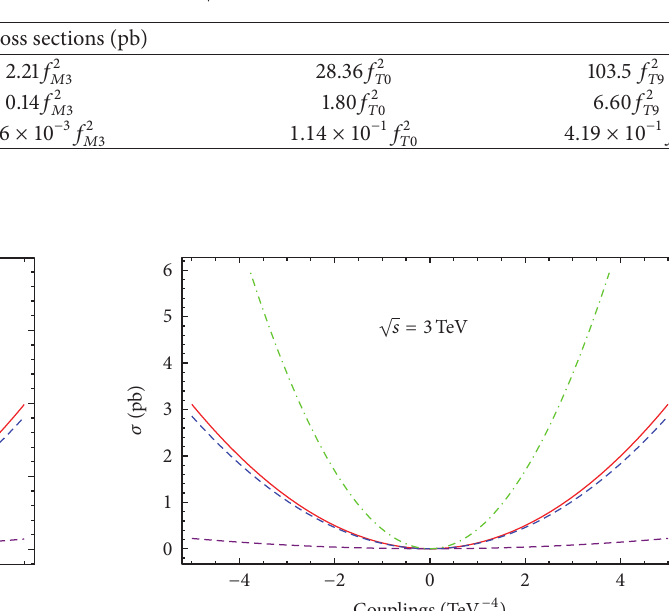
Table1:Thetotalcrosssectionsasfunctionofanomalous 𝑓 𝑀2 /Λ 4 , 𝑓 𝑀3 /Λ 4 , 𝑓 𝑇0 /Λ 4 ,and 𝑓 𝑇9 /Λ 4 couplingsassuming Λ =1TeVfortheprocesses 𝛾𝛾 → 𝑍𝑍